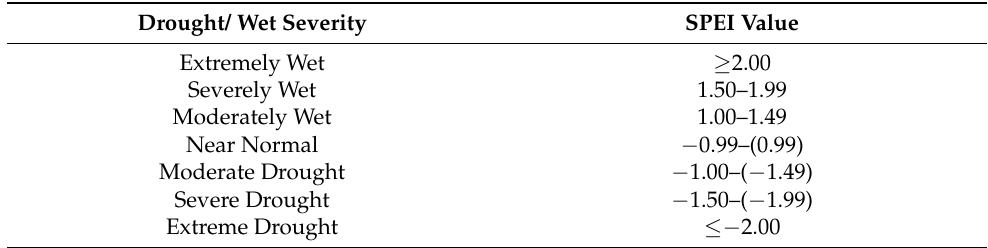
Table 3. The Standardised Precipitation-Evapotranspiration Index (SPEI) categories based on the classification of SPEI values by [58].